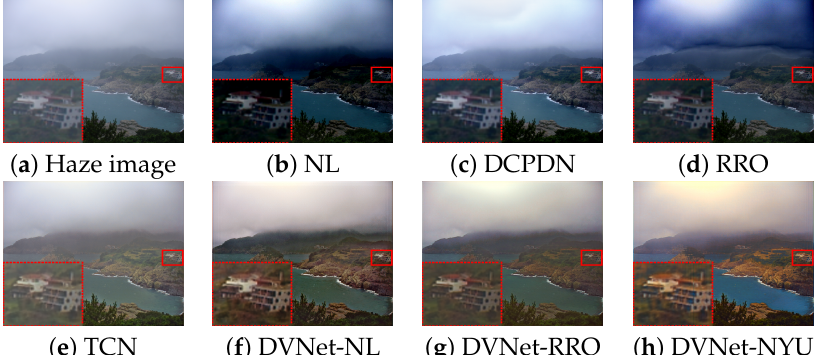
Figure 8. Dehazing results using real-world dataset: The red desh-shaped box denotes a zoomed region in the red box.